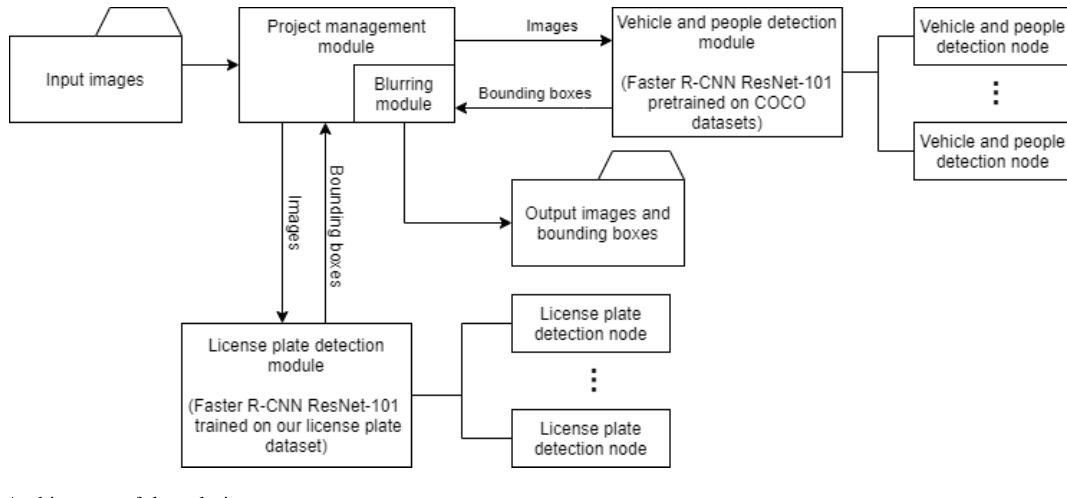
Figure 1. Architecture of the solution. Table 1. Specifications of computer used for